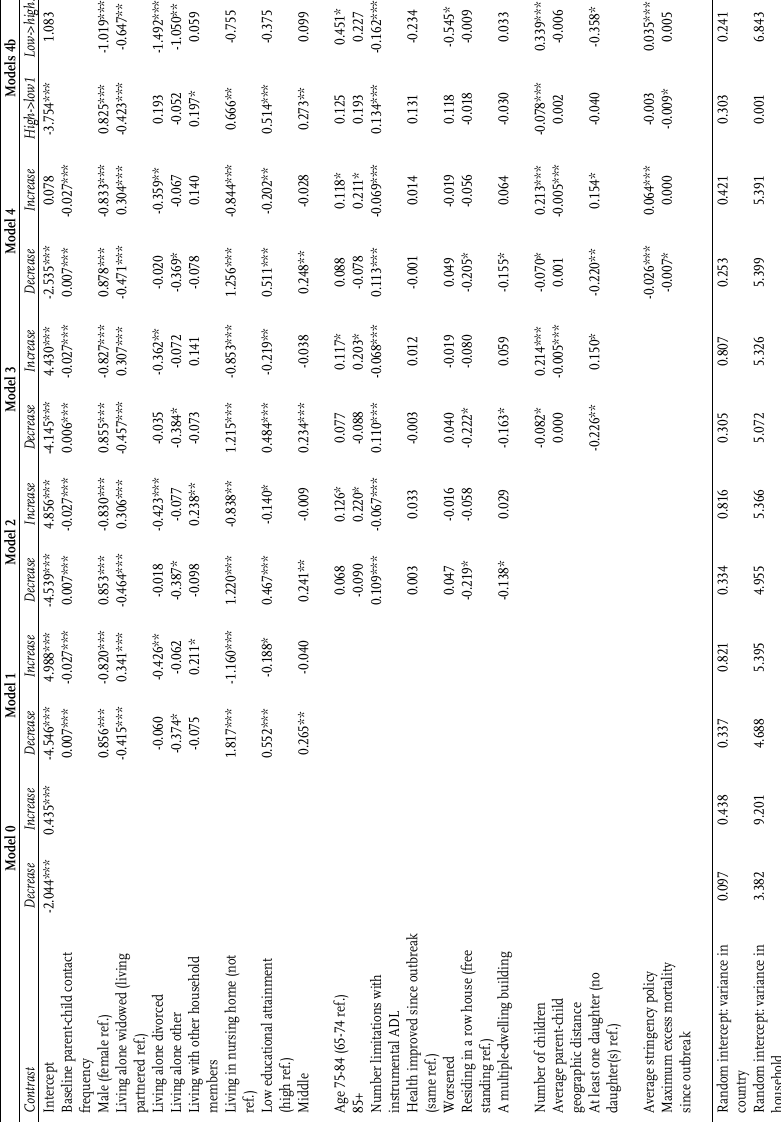
Table 3: Regression coefficients of three-level multinomial logistic regression analysis of parent-child contact changes (no change ref.) (Model 1-5) and three-level binomial logistic regression analysis of substantial parent-child contact changes conditional on pre-COVID-19 level (varying ref. category) (Models